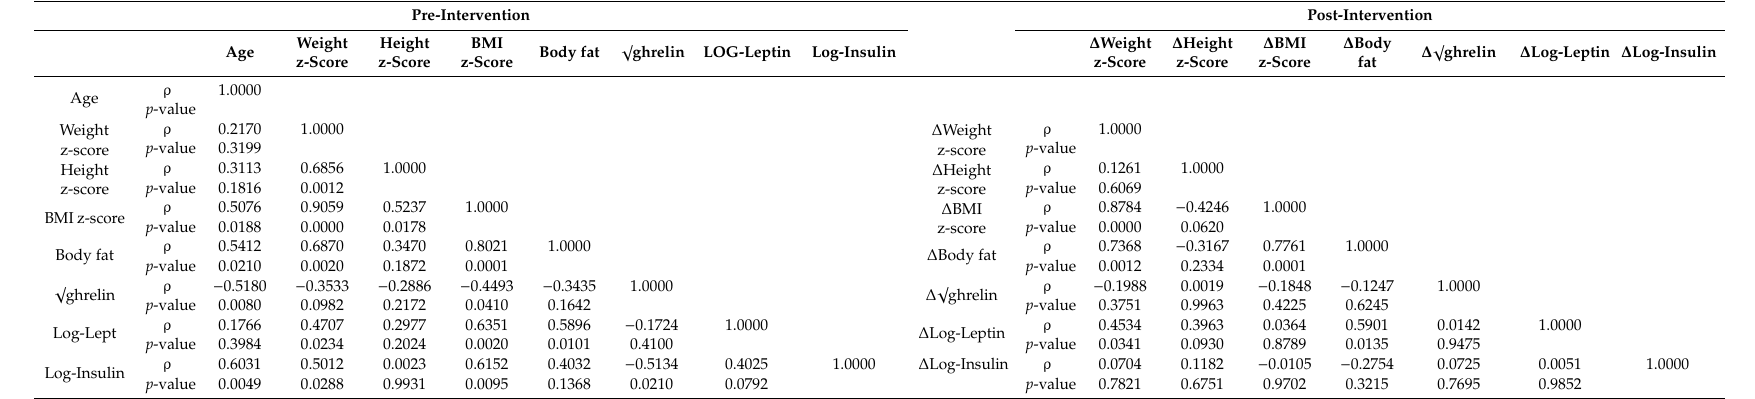
Table 4. Associations between nutritional status, body composition, ghrelin and leptin at the baseline and 12-months in children and adolescents. Pre-Intervention